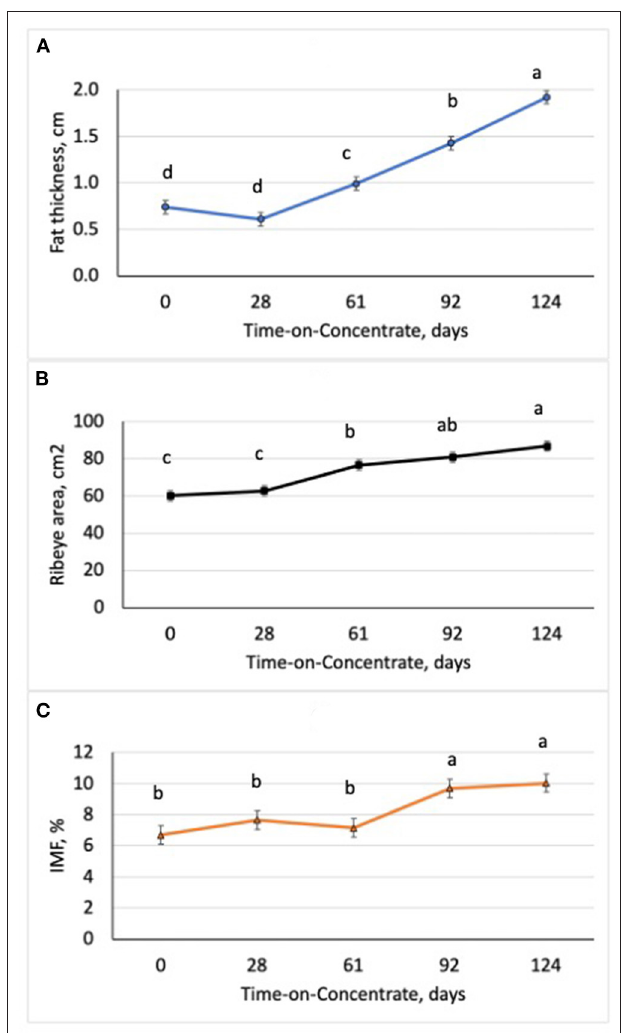
FIGURE 1 | Changes in ultrasound fat thickness (A) , ribeye area (B) , and intramuscular fat content (IMF; C ) in steers ( n = 7/time) with increasing time-on-concentrates. abc Means with uncommon superscripts differ ( P < 0.01) for each graph.